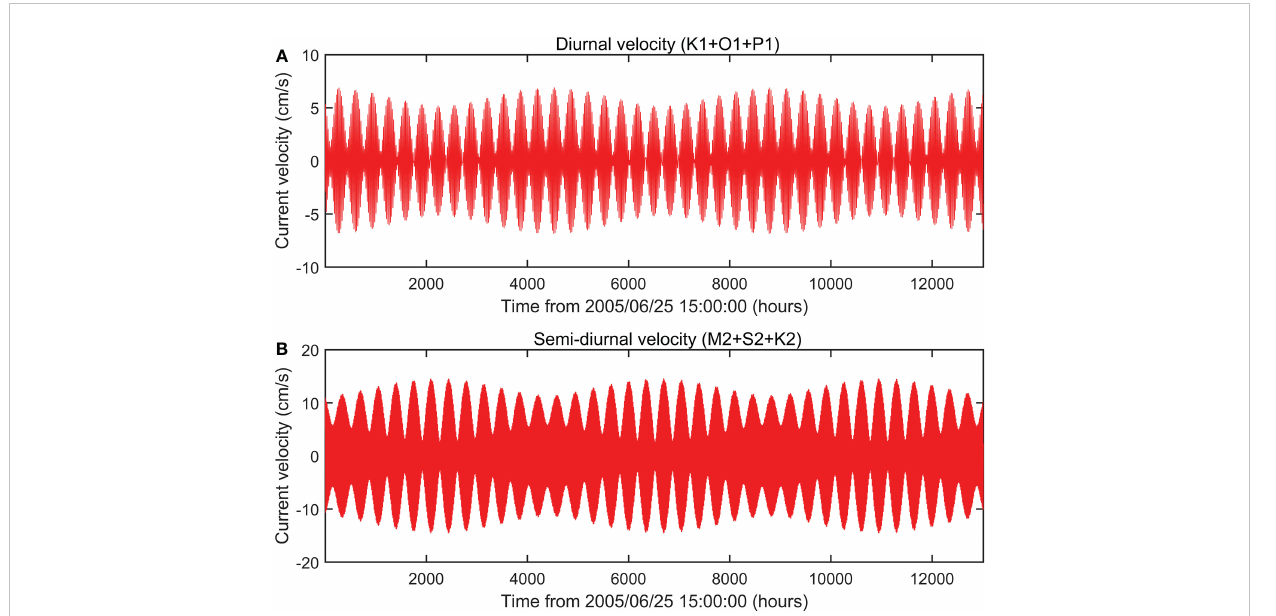
FIGURE 3 (A) The combination of observed K 1 , O 1 , and P 1 tidal currents. (B) The combination of observed M 2 , S 2 , and K 2 tidal currents. Note that the results are estimated from currents along the